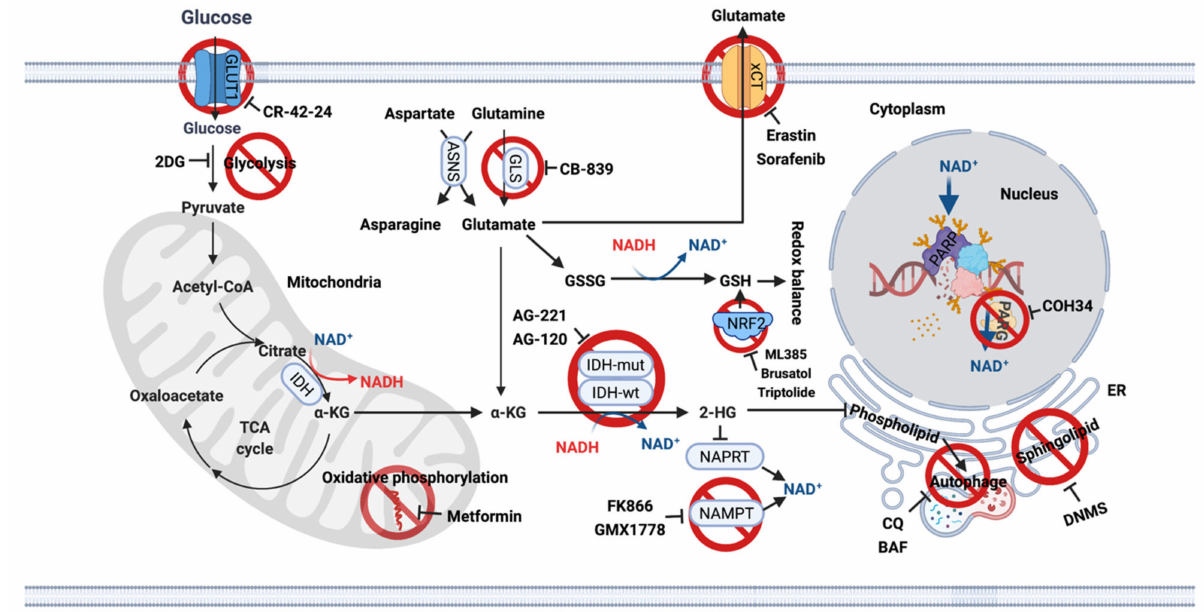
Figure 2. Metabolic vulnerabilities in IDH-mutant gliomas and potential targets for single treatment or combination treatment with TMZ. Actionable metabolic dependencies in IDH-mutant gliomas include interrupted redox balance, low basal levels of glutamate, NAD+ and lipid synthesis. ASNS, Asparagine synthetase; BAF, Bafilomycin A1; CQ, Chloroquine; 2DG, 2-Deoxy-D-glucose; DNMS, N,N-dimethylsphingosine; ER, Endoplasmic reticulum; GLS, Glutaminase; IDH, Isocitrate dehydrogenase; NAD+, Nicotinamide adenine dinucleotide; NAMPT, Nicotinamide phosphoribosyl transferase; NAPRT, Nicotinate phosphoribosyltransferase; NRF2, nuclear factor erythroid 2-related factor; PARP, Poly (ADP-ribose) polymerse; PARG, Poly (ADP-ribose)